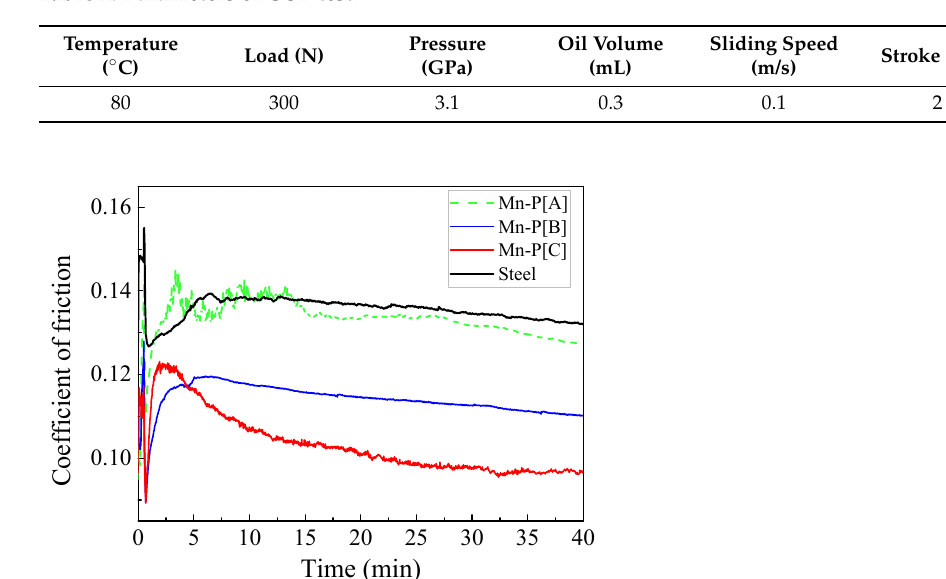
Table 2. Parameters of COF test.